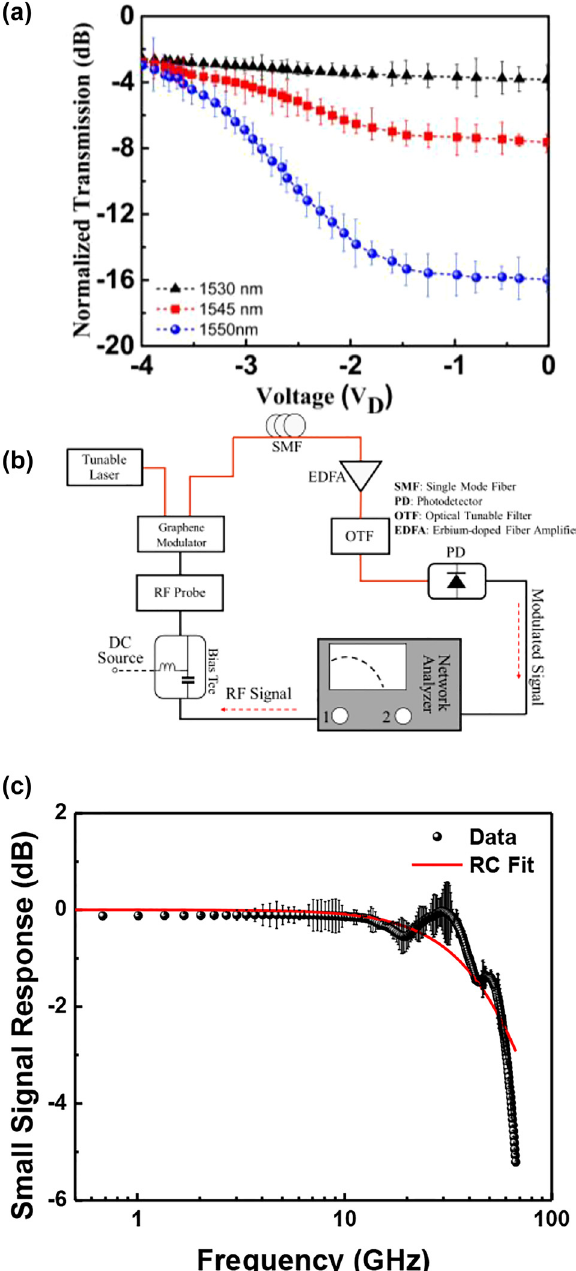
Figure 3: Electro-optical response (a) Electro-optical response of the device at different drive voltage for wavelength of 1530 nm, 1545 nm, 1550 nm. As we move from 1530 nm to 1550 nm, the angle of light moves to vertical and light matter interaction enhances so the modulation depth improves. The modulation depth of the modulator is estimated to be 5.2 dB/V. (b) In-house small-signal RF setup (S 21 : ratio between optical amplitude modulation and RF signal), and (c) normalized RF response of the double layer graphene optical modulator. The 3 dB cut-off frequency of 60 GHz was